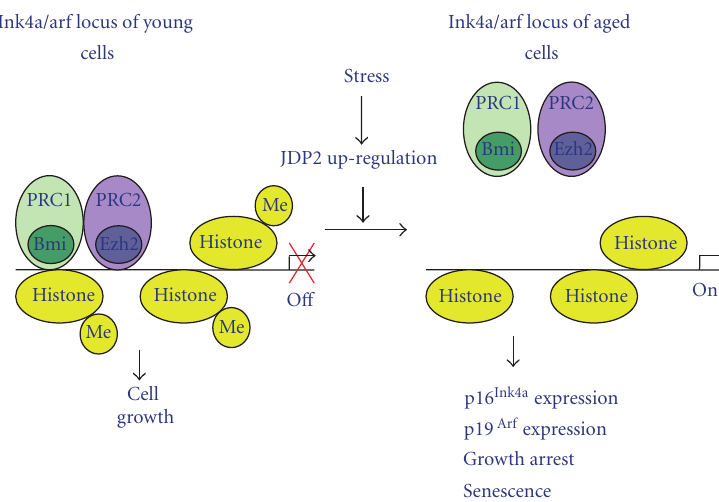
Figure 3: Proposed model of the epigenetic regulation of the expression of the genes for p16 Ink4a and Arf by JDP2. The exposure of young MEF primary cells to aging stress leads to the accumulation of JDP2. JDP2 binds to histones and inhibits the methylation of H3K27 at the p 16 Ink 4 a / Arf locus. As a result, PRC-1 and PRC-2 fail to form stable repressive complexes and are released from the locus. The consequent expression of p16 Ink4a and Arf in the aged cells leads to growth arrest and senescence